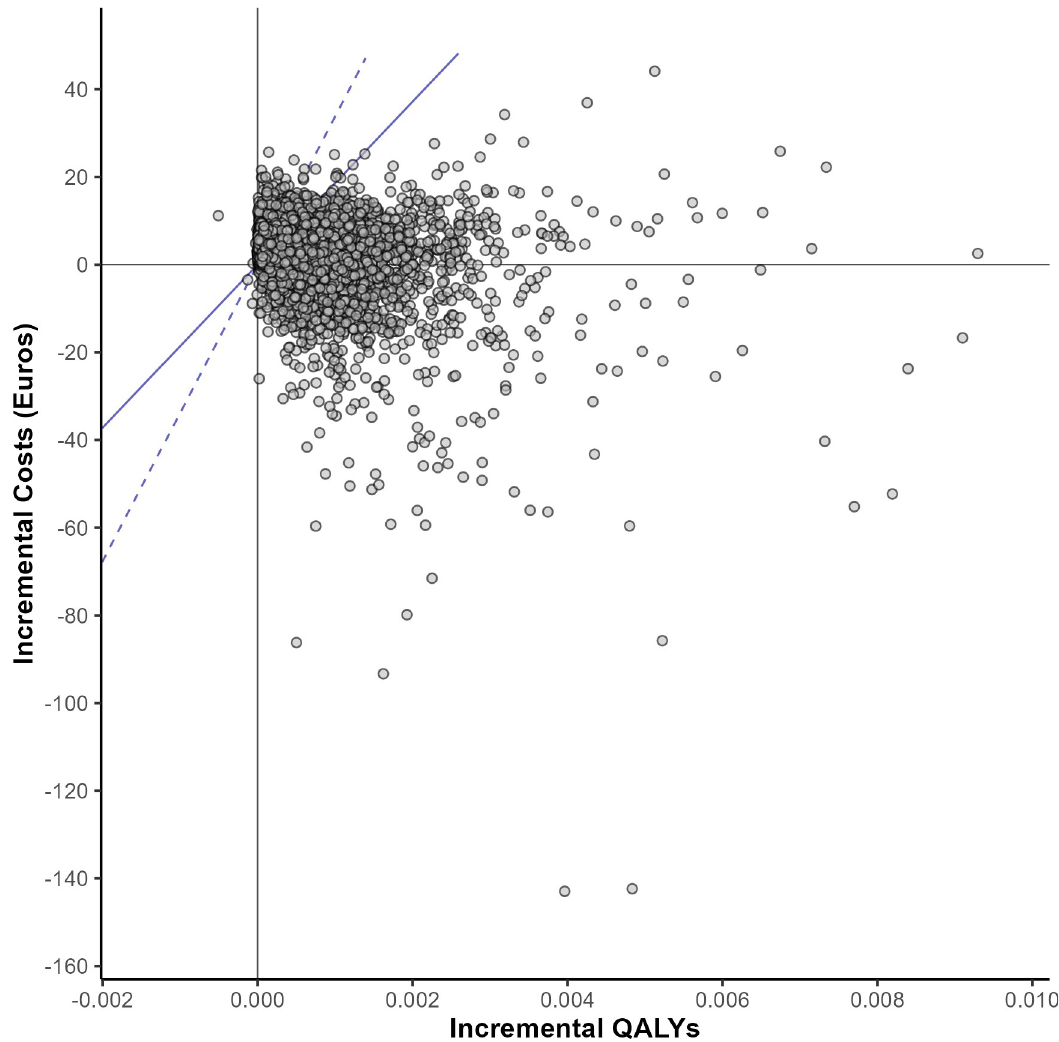
Fig 5. Cost-effectiveness plane. Lines indicate WTP thresholds of € 18,592 (plain) and € 33,817